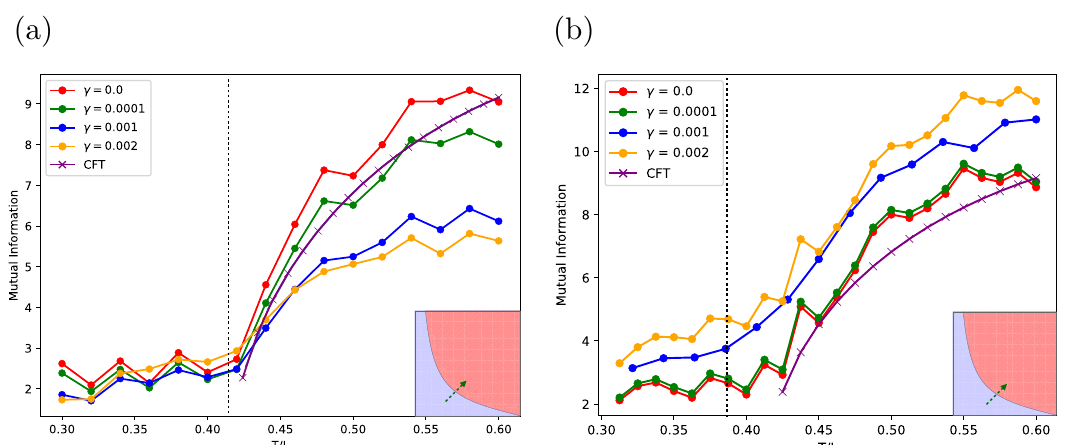
Figure 8: Scaling of mutual information in the heating phase T and L = 200, for different values of dissipation γ = Γ L R = 0.1, (a) no dissipation, γ = 0, (b) γ = 0.0001, (c) γ = 0.001, (d) γ = 0.002.